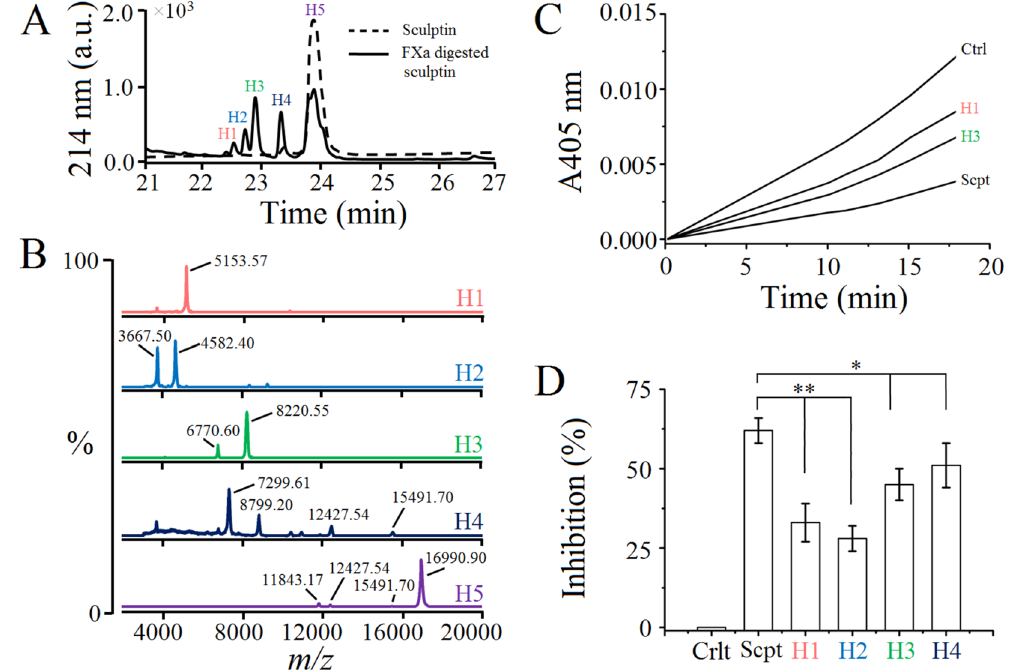
Figure 6. Thrombin inhibition activity of sculptin fragments generated by factor Xa. Sculptin (10 µ M) was incubated without or with 1 µ M of factor Xa in 50 mM phosphate buffer containing 150 mM NaCl, and 50 µ M phosphatidylserine and phosphatidylcholine, pH 7.4 for 6 h at 37 °C. ( A ) The reaction mixtures were separated by reversed phase C-18 HPLC column. ( B ) The collected peaks (H1–H5) were subjected to MALDI-TOF MS and thrombin inhibition assay (see Table 1, for sequence of the corresponding peptides). ( C ) Typical progress curves for hydrolysis of 15 µ M S-2238 chromogenic substrate by 0.1 nM thrombin in the absence (trace Ctrl) and presence of 100 pM of sculptin fragment (traces H1 and H3) or intact sculptin (trance Scpt) in 50 mM phosphate buffer containing 150 mM NaCl and 0.1% PEG 6000, pH 7.4 at 37 °C. ( D ) Percent thrombin inhibition by sculptin and its fragments. The reaction conditions of ( D ) are same as in ( C ). The results shown in ( D ) correspond to the mean ± standard deviation values acquired in three independent experiments; ** p < 0.01 and * p <